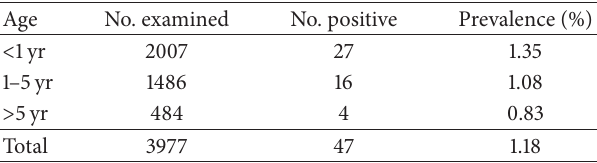
Table 1: Seasonal prevalence of Sarcoptes scabiei in pet dogs in Guangzhou, southern China.